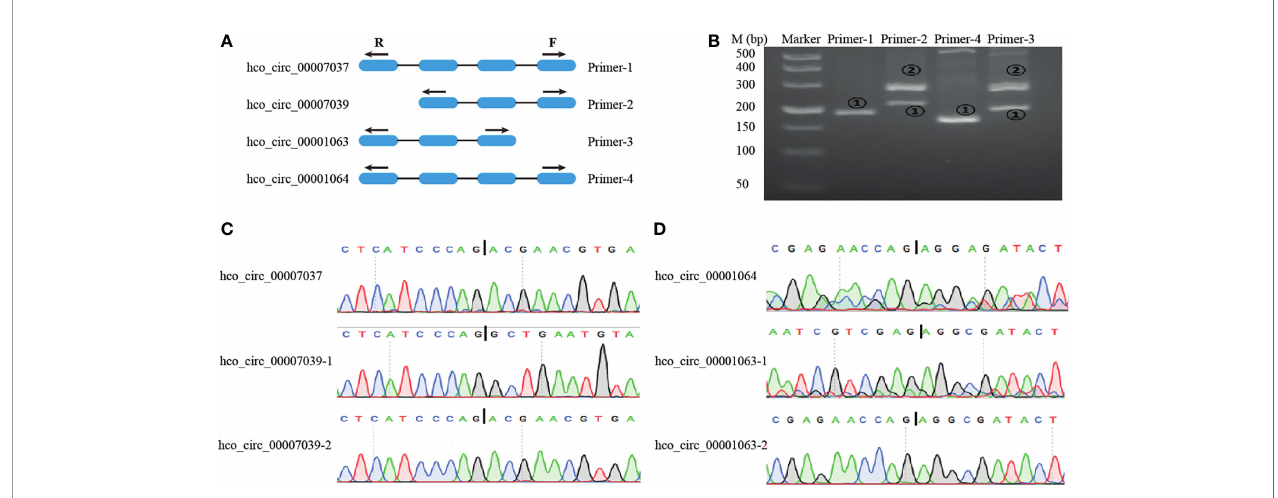
FIGURE 7 | Visualization and validation of two alternative back-splicing circularization events. (A) A schematic diagram of the divergent primers designed for alternative splicing event. (B) Representative PCR products ampli fi ed with primers presented in (A) were examined by 3% agarose electrophoresis. M: 500 bp ladder DNA marker. (C, D) Sanger sequencing to validate the backsplice sites. Vertical Bar represents the backsplice junction